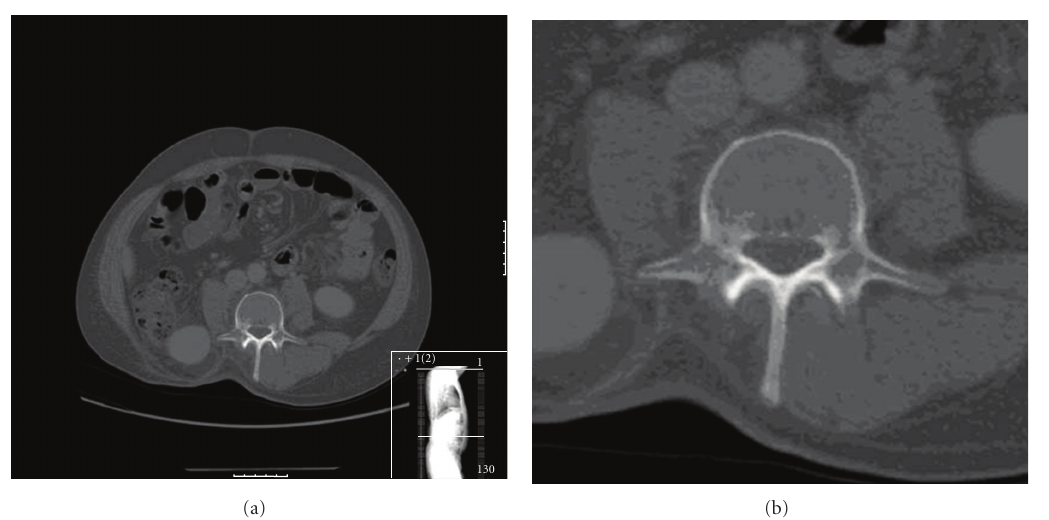
Figure 2: There is a right-sided paraspinal metastatic lesion. The bone windows on CT scan show very subtle lytic change in the vertebral body of L2 which was not considered significant at the time of